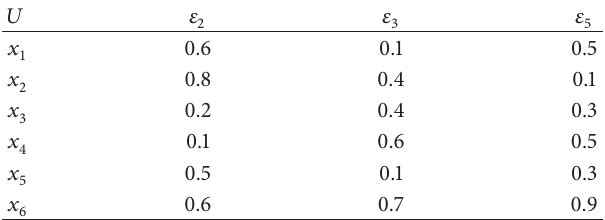
Table 5: Tabular representation of (𝐽, 𝐷) .